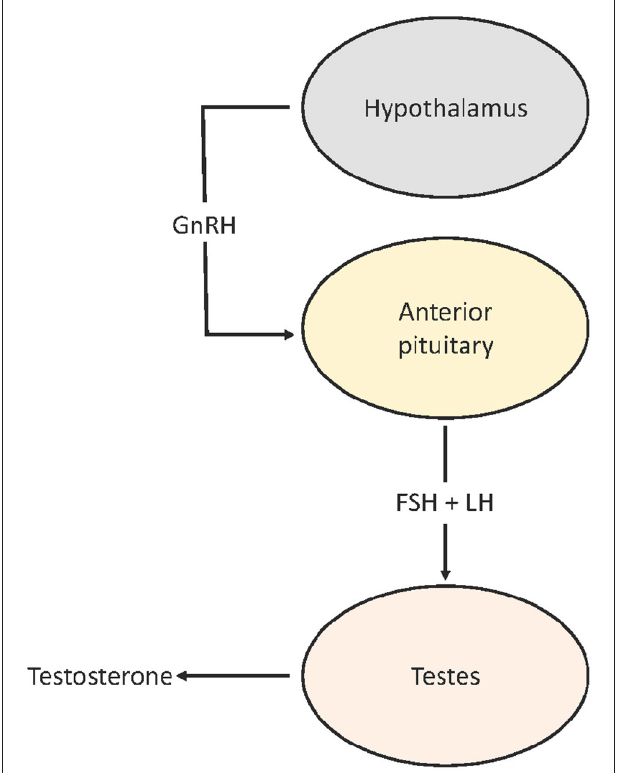
FIGURE 1 | Simplified HPG axis. GnRH released by the hypothalamus reaches the anterior pituitary where it stimulates production and release of FSH and LH which enter the general circulation. When LH and FSH bind to receptors on the testes (FSHR and LHR) in early spring, testes grow and increase testosterone